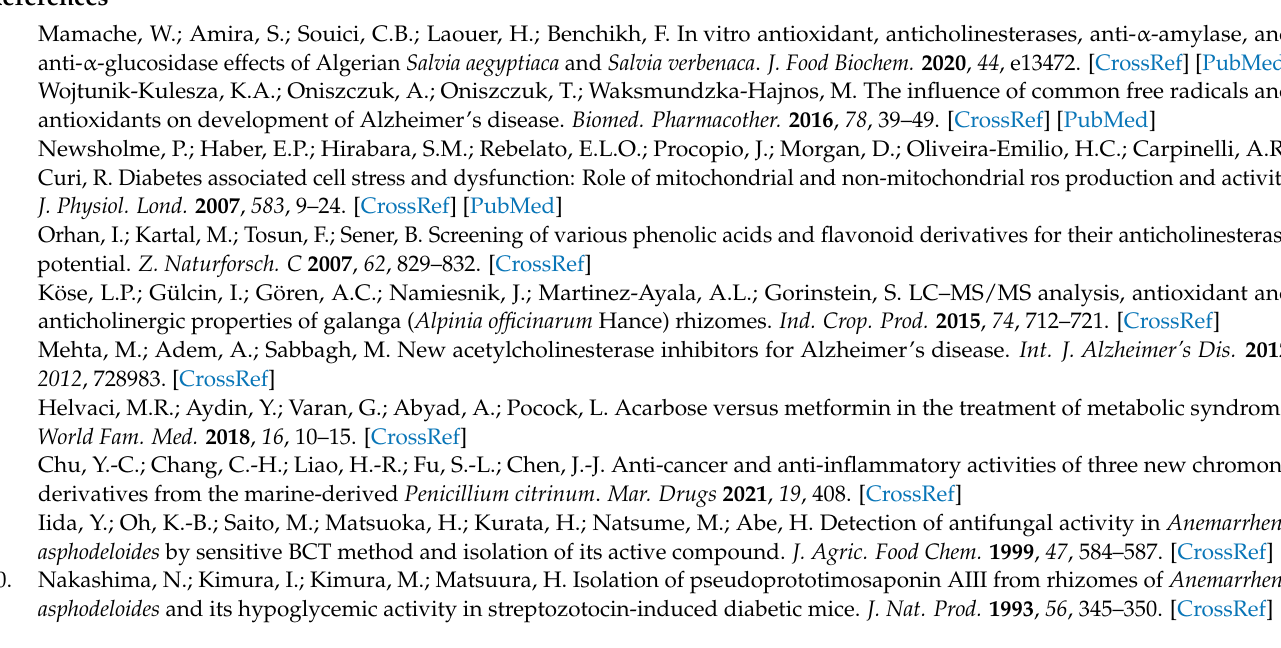
Figure S15: Reverse-phase HPLC chromatogram of n -hexane extract in salt-fried